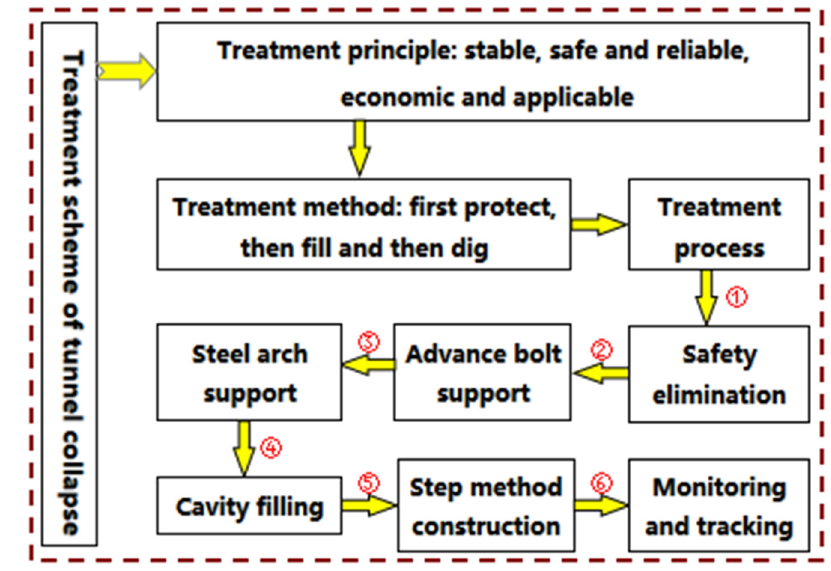
Figure 6. Flow chart of tunnel collapse treatment.